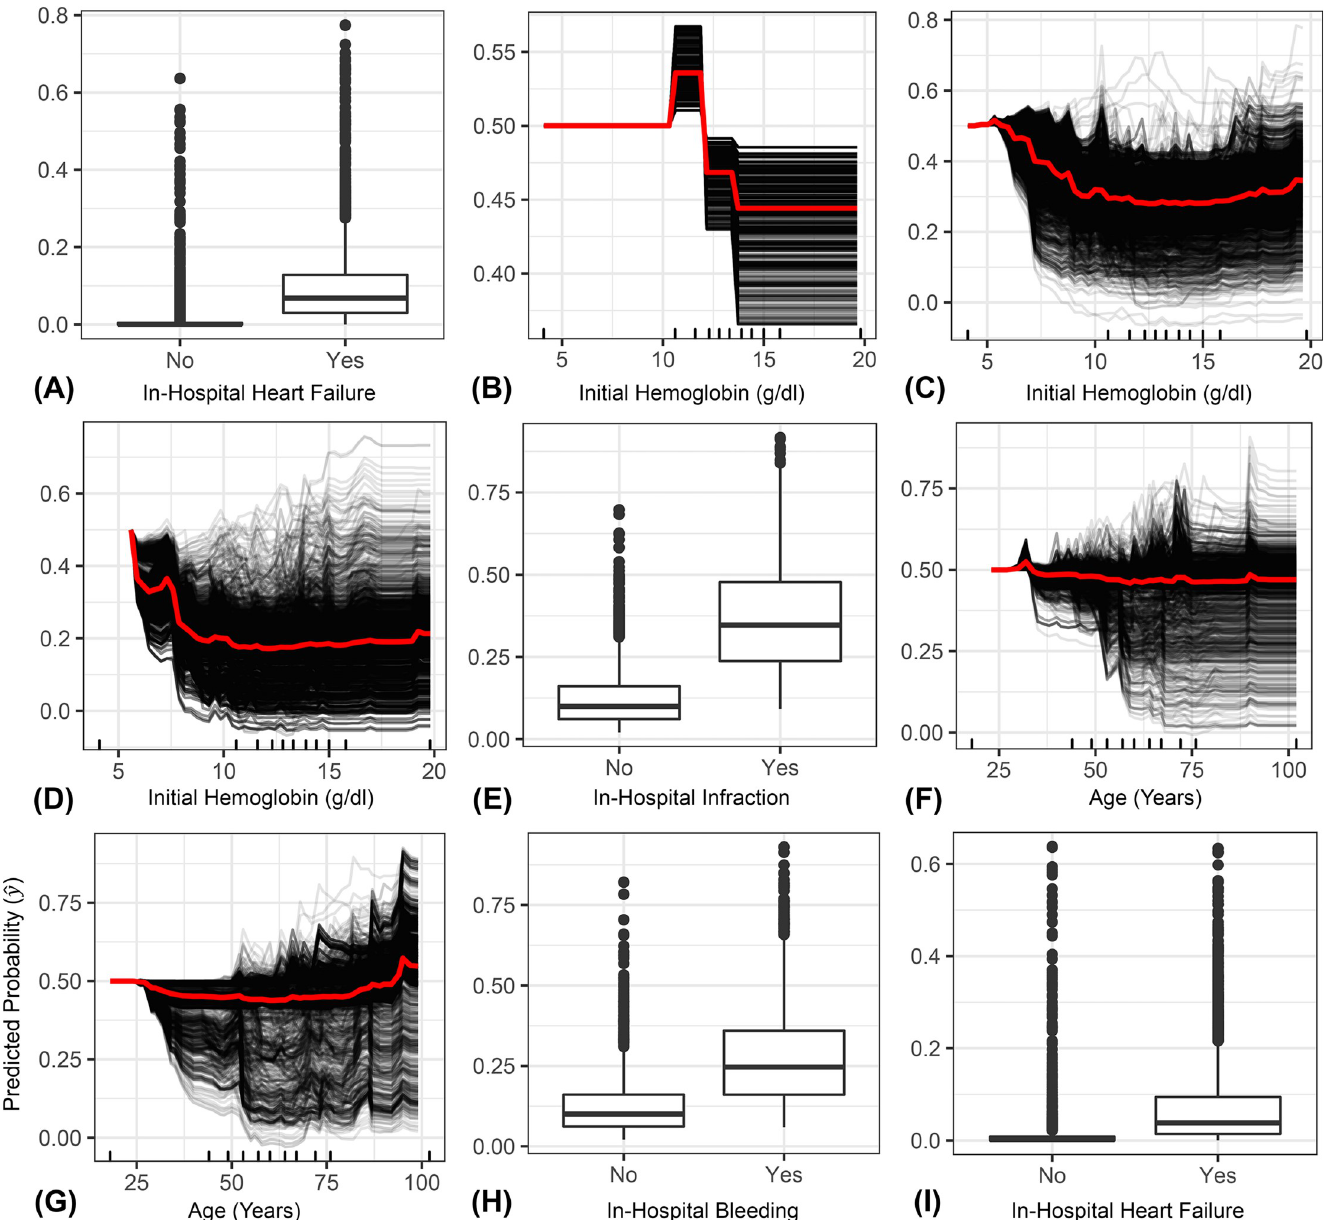
Fig 2. Centred Individual Conditional Expectation (ICE) plots for the top three important features that contribute to the prediction of three in-hospital ACS outcomes, including (A, D, G) mortality, (B, E, H) heart failure, and (C, F, I) bleeding. The plots show the relationship between the predicted risk of ACS outcomes and each corresponding feature. The black lines indicate the predicted risk in each patient, while the red line indicates the partial dependence calculated as the average risk across all patients.